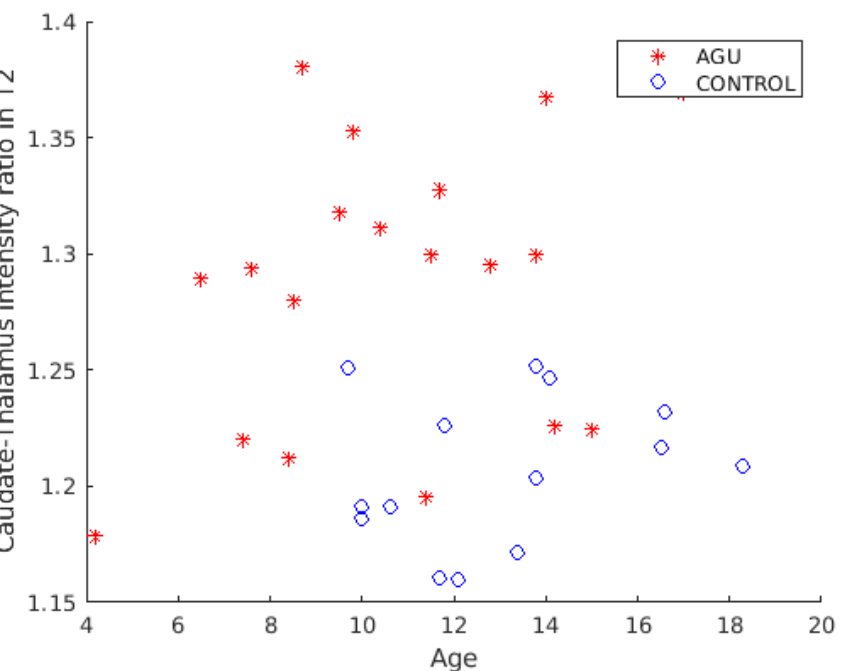
7 of 13 Figure 2. Normalized total thalamus volume (as sum of thalamus nucleic volumes) plotted against caudate-thalamus intensity ratio in the T2-weighted images. The patients and the controls were less separated by the x -axis than the y -axis. To investigate the effects of age on the caudate-thalamus intensity ratio classifier fea- ture, the intensity ratio was plotted against the subject ’s age . Figure 3 shows a scatter plot